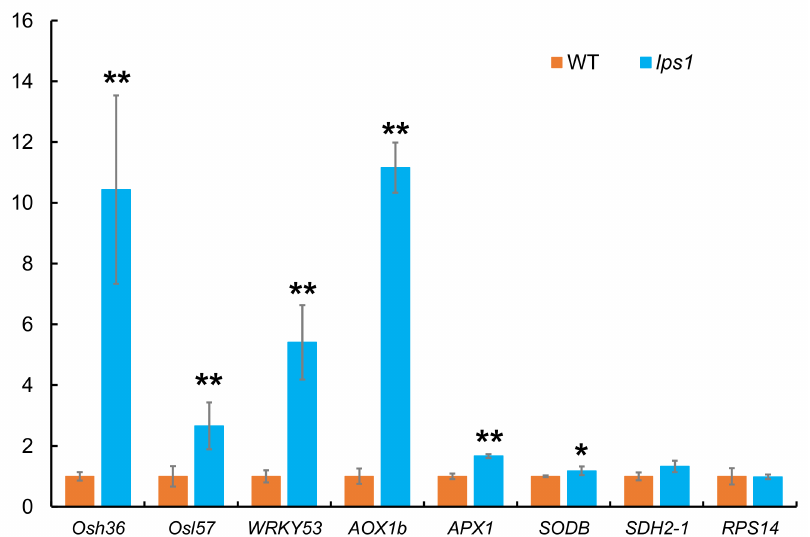
Figure 13. Expression analysis of senescence-associated and ROS detoxification-associated genes in flag leaves of wild type and lps1 mutant at heading stage by qRT-PCR. The expression level of each gene in the wild type was set to 1.0, and those in lps1 mutant were calculated accordingly. Error bars represent standard deviations of three independent biological replicates. The statistically significant differences were performed by Student’s t test. * p < 0.05 and ** p <